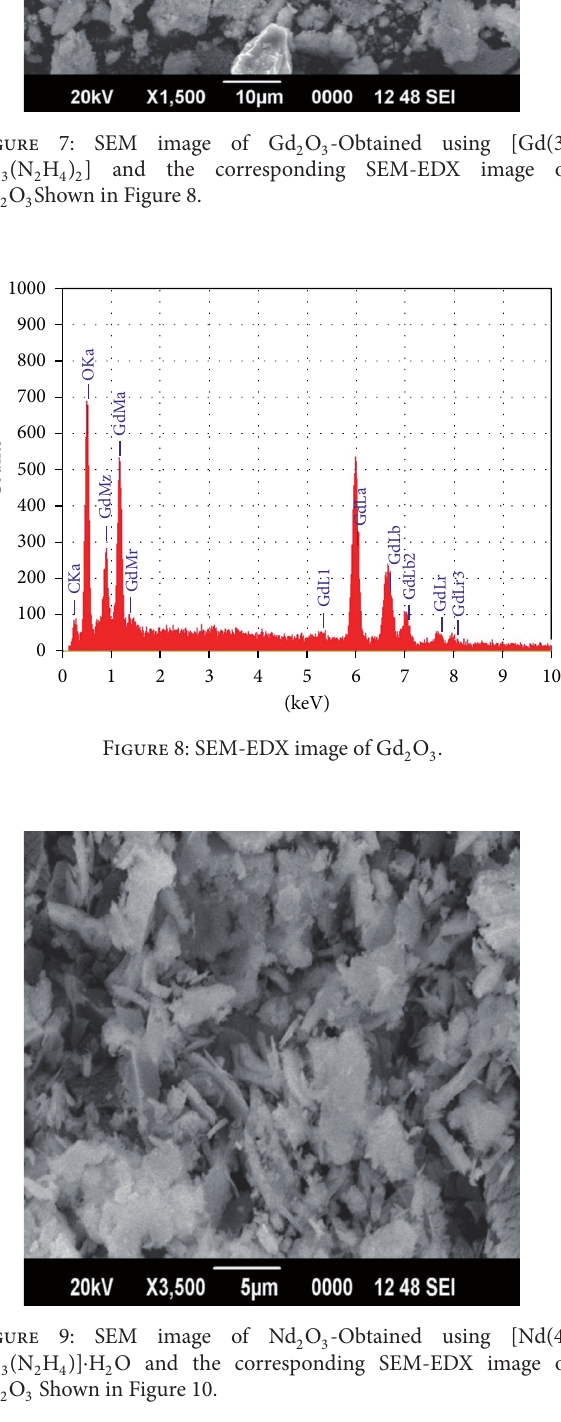
O -Obtained using [Nd(4- 2 3